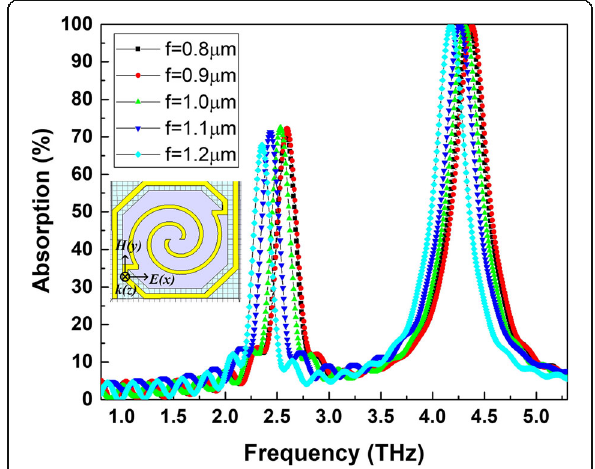
Fig. 8 THz wave absorption curves of spiral-type antenna-coupled micro-bridge structures with two connected linear antennas on the bridge legs for different line width ( f )